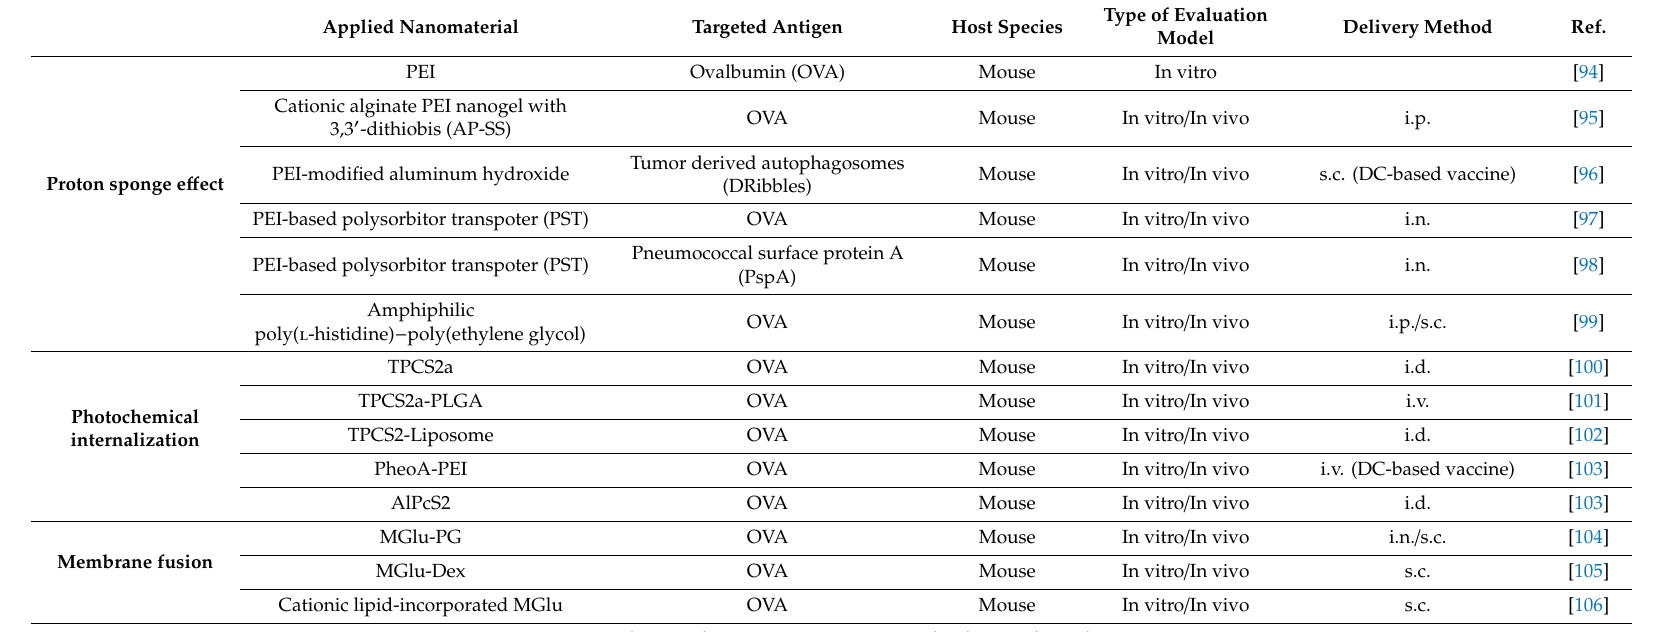
Table 1. Nanovaccines inducing cytosol exportation for cellular immune